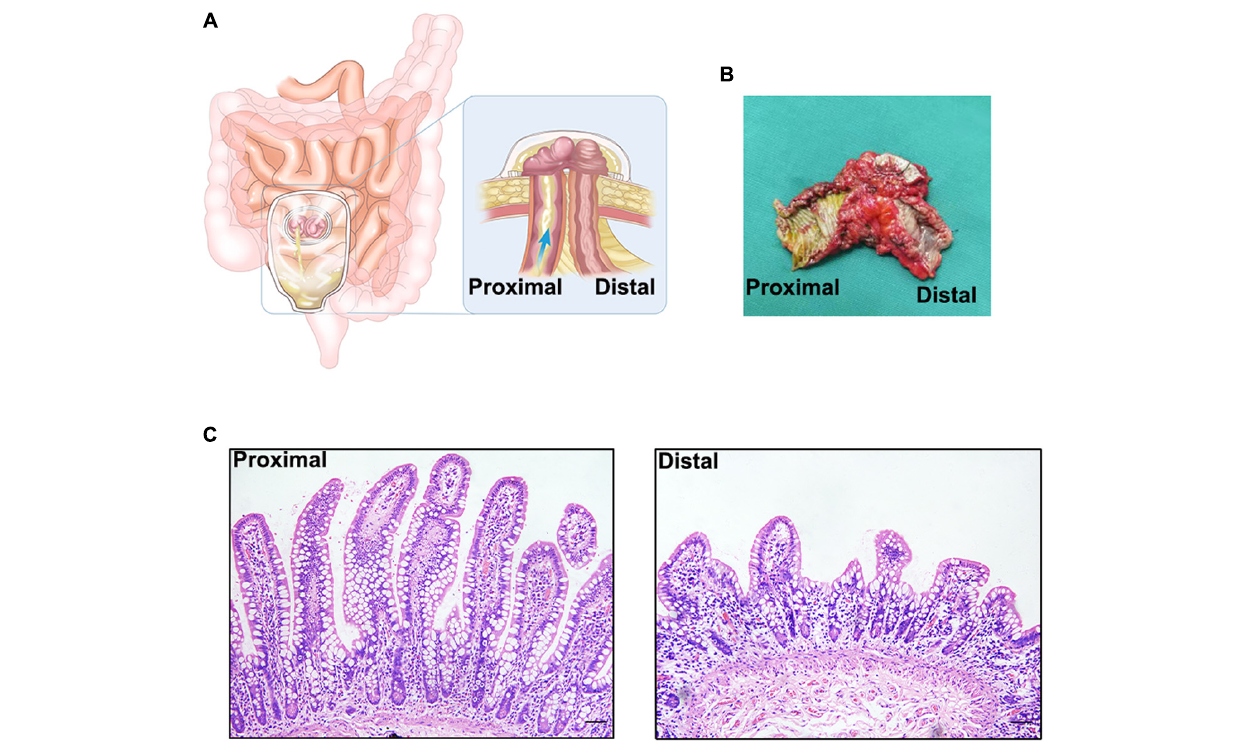
FIGURE 1 | (A) . Schematic diagram of an ileostomy. (B) Ileal tissue from an ileostomy reversal, there is a significant difference between the proximal and distal intestinal tissue by visual inspection. (C) Hematoxylin-eosin staining of proximal and distal intestinal tissues. There is a significant atrophy in distal intestinal